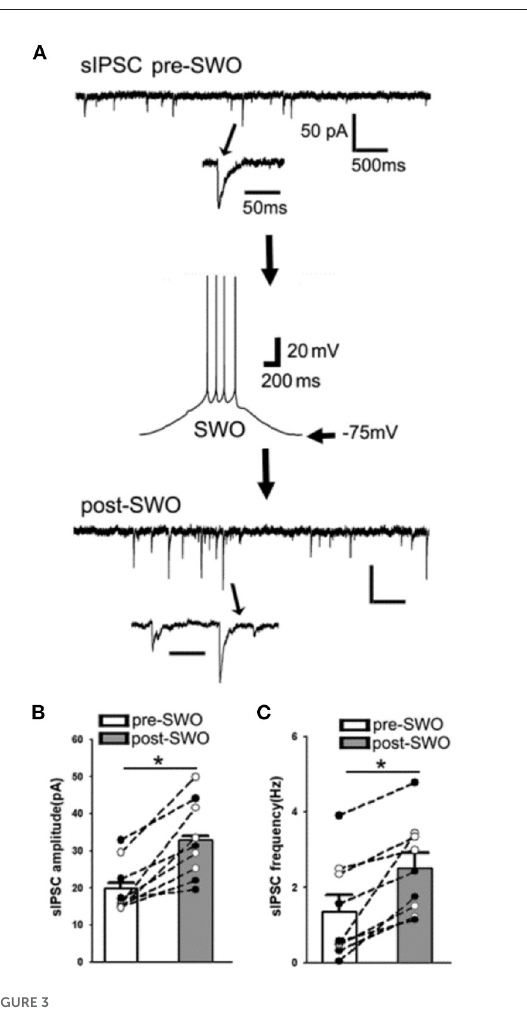
FIGURE3 Artificial SWO induction potentiates spontaneous inhibitory synaptic currents (sIPSCs) in layer V cortical neurons. (A) One representative pre- (top) and post-SWO sIPSC (below) in layer V cortical neurons and the middle panel shows one SWO. Individual sIPSC events (with arrow indicating) are expanded in a small temporal scale. Scale bars are indicated as labeled. (B) Shows the summary data of pre- (empty bar) and post-SWO (gray bar) sIPSC amplitudes from the same cortical neurons (dots connected with one line). (C) Shows the summary data of pre- (empty bar) and post-SWO (gray bar) sIPSC frequencies from the same cortical neurons (dots connected with one line). *Indicates a significant difference p <